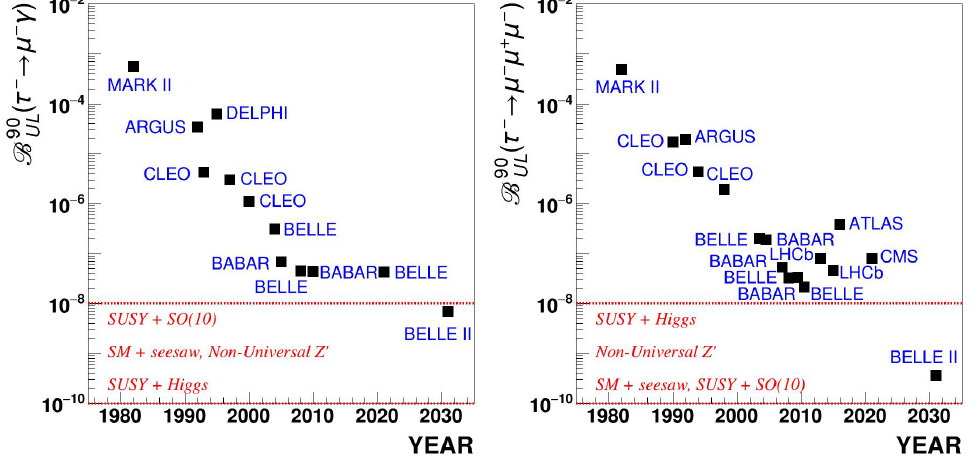
Figure 8. Evolution of experimental bounds on τ − → µ − γ [69–71,94,95,115–120] (left) and τ − → µ − µ + µ − [36,76,78,102,104–106,115,116,121–126] decays, future prospects at Belle II [40] and some predictions from Table